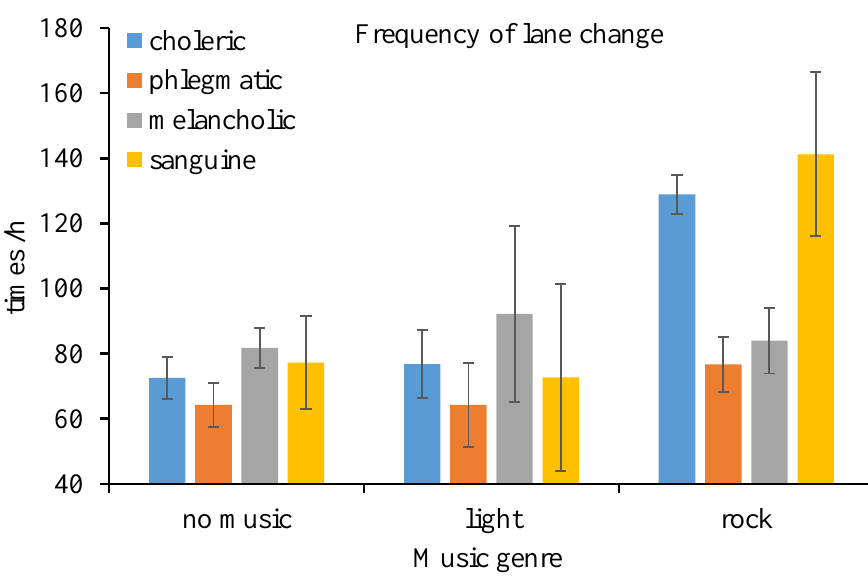
Figure 6. Frequency of lane change (and standard error) by music genre and personality.